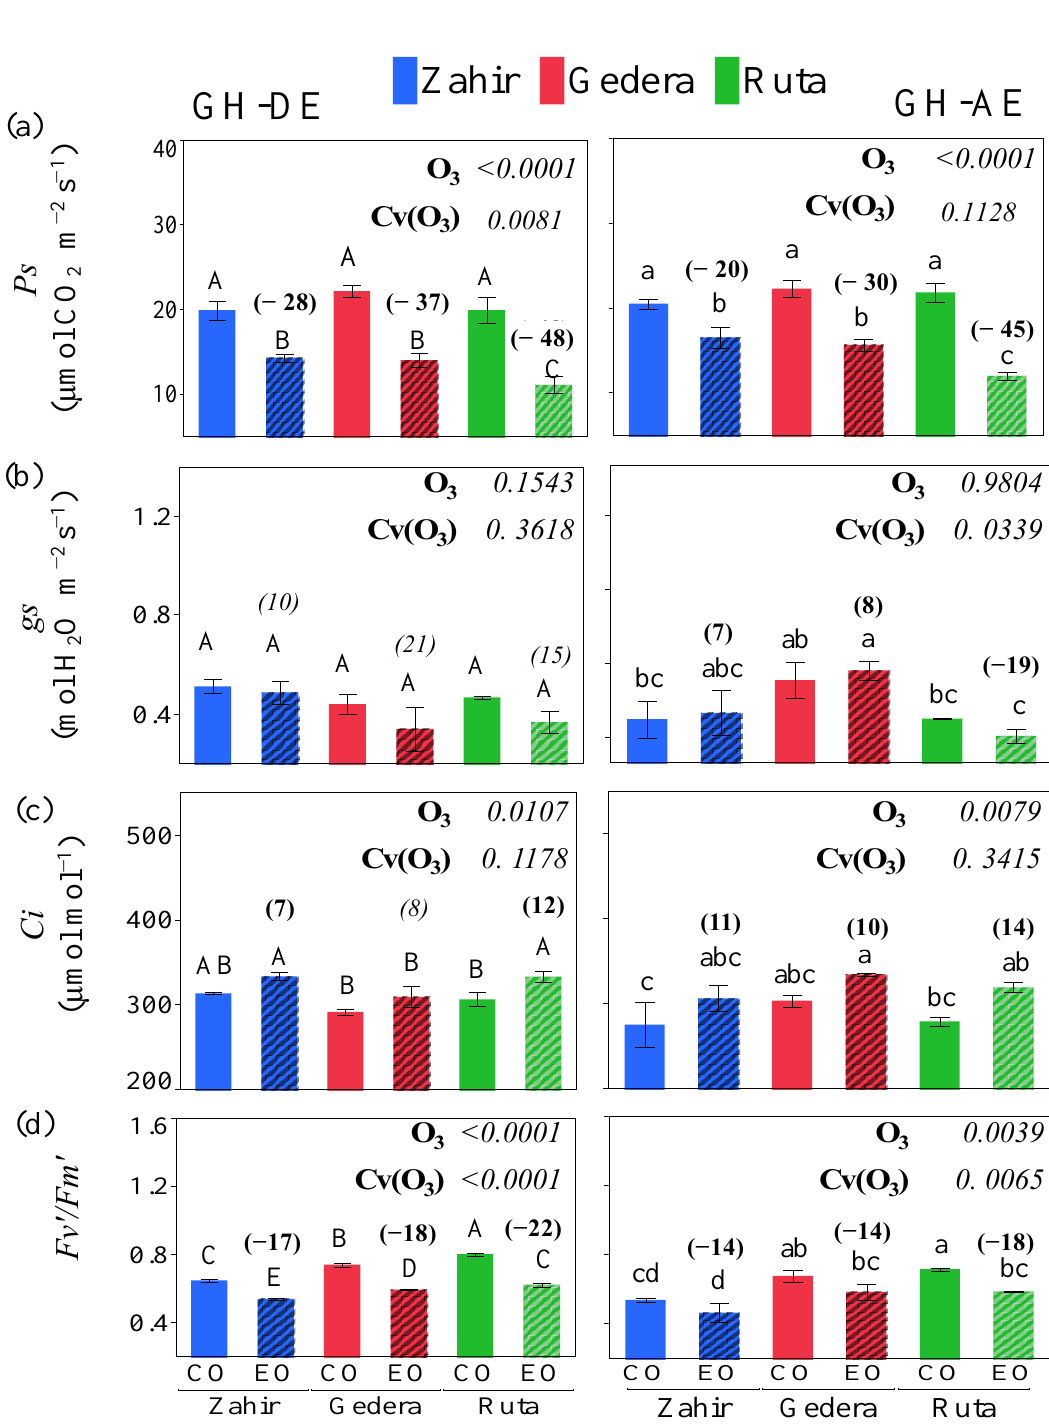
Figure 5. GH experiment. Results (mean ± SE, n = 5) for ( a ) photosynthetic rate; Ps (µmol CO 2 m −2 s −1 ), ( b ) stomatal conductance; gs (mol H 2 O m −2 s −1 ), ( c ) intercellular CO 2 ; Ci (µmol mol −1 ), and ( d ) photochemical efficiency ( Fv ′ /Fm ′ ), individually during O 3 exposure (GH-DE) and after O 3 exposure (GH-AE) for GHs enriched with O 3 (EO) and their corresponding control (CO). Different letters above the bars indicate significant differences ( p < 0.05) according to Student’s t -test. Italicized numbers in parentheses above the bars represent insignificant percentage change, and non-italicized numbers in parentheses indicate significant percentage change for all parameters between control and O 3 -exposed GHs during exposure (GH-DE) and afterward (GH-AE). p -values of factors O 3 exposure (O 3 ) and cultivar within O 3 effect Cv(O 3 ) by ANOVA are also shown.